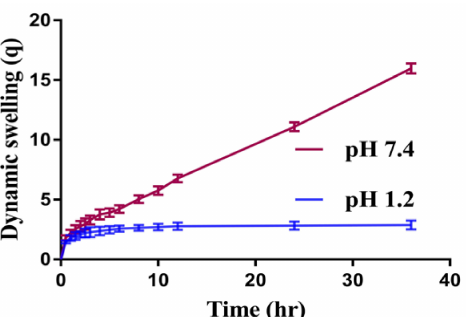
Figure 1. Effect of pH on dynamic swelling of SPSPAA